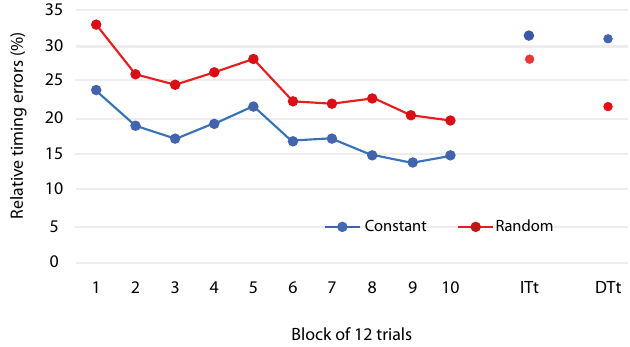
Figure 2 . Relative timing errors ( A E prop) in acquisition (blocks 1-10), immediate transfer test (ITt) and delayed transfer test (DTt).